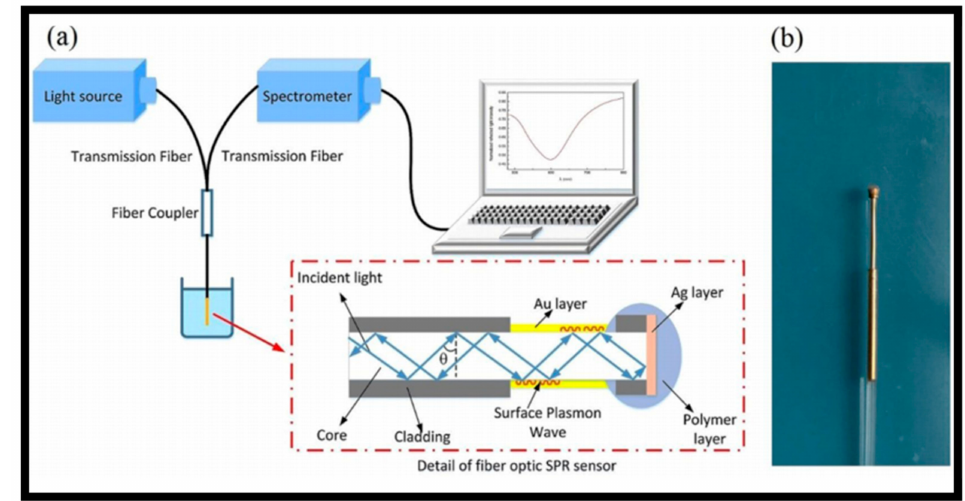
Figure 8. Surface plasmon resonance (SPR)-based fiber optic sensing technique: ( a ) graphic illustra- tion of the experimental arrangement. Reprinted from ref. [99]; ( b ) picture of the manufactured fiber optic SPR sensor. Reprinted from ref.